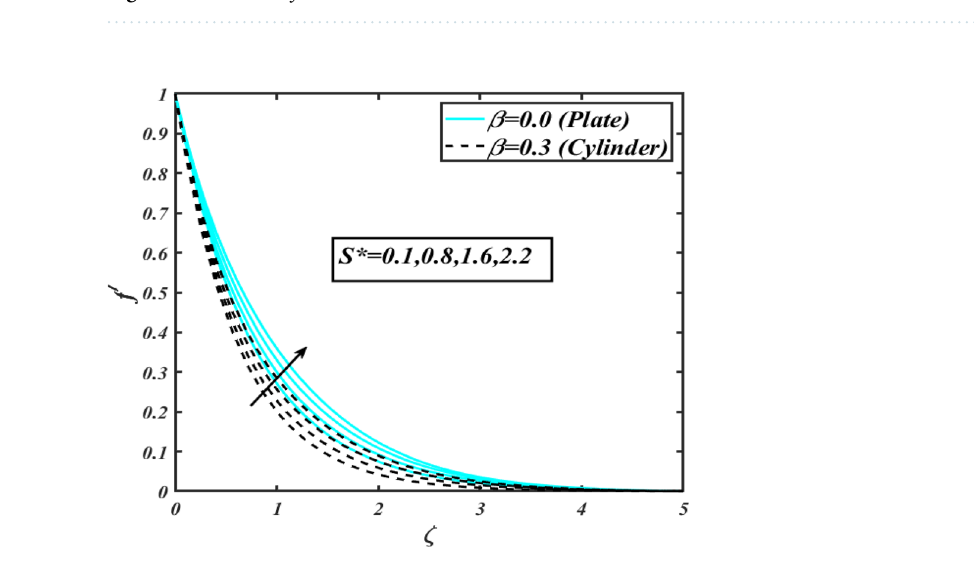
Figure 6. Profile of f ′ for A 2 .